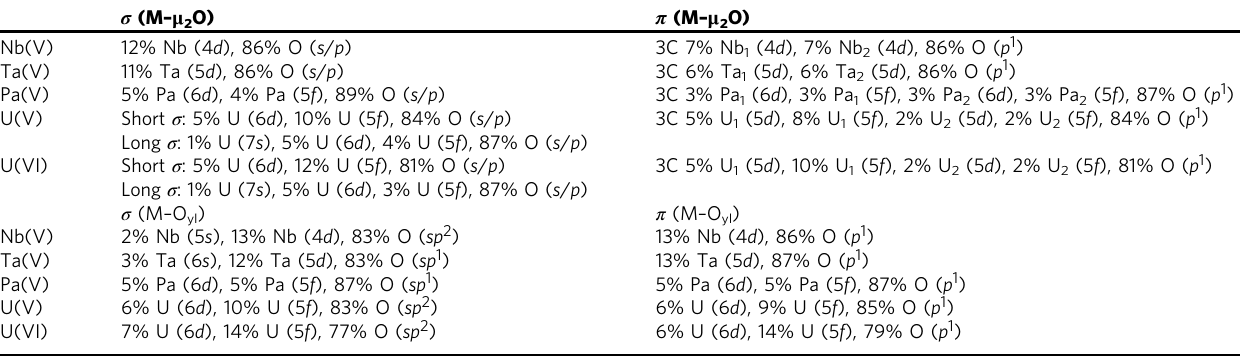
Table 4 Atomic orbital contributions to the natural localized molecular orbitals in the in the [M 6 O 19 ] 8 – clusters σ (M – μ 2 O)